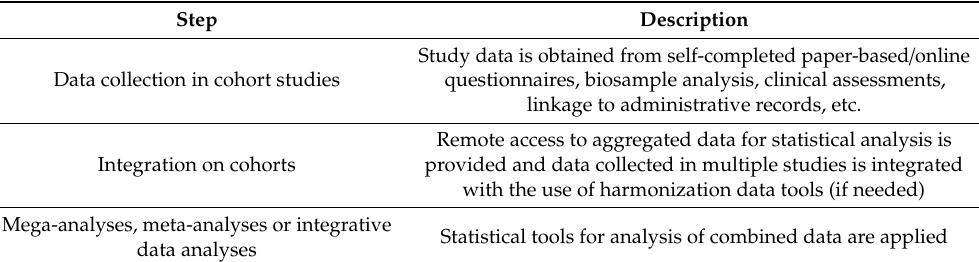
Table 1. Main Steps of Federated Facility